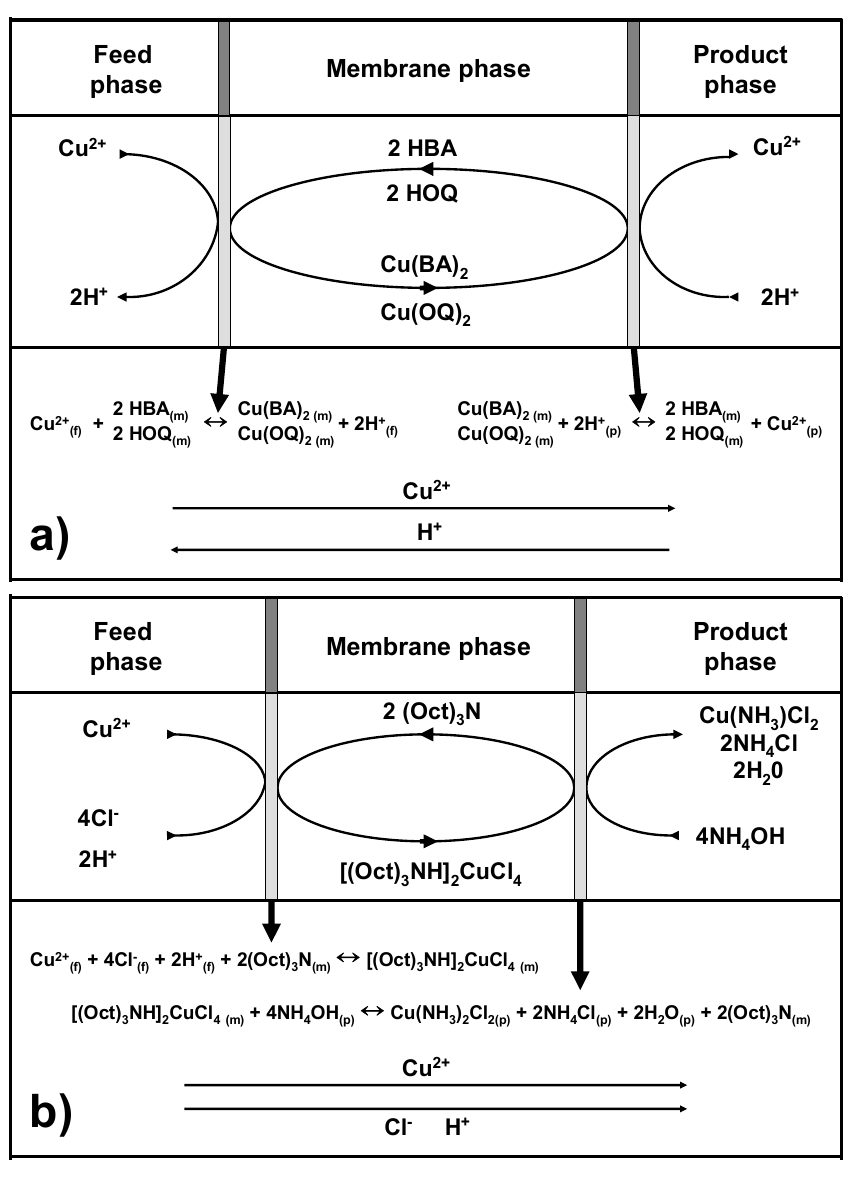
Figure 2. Facilitated transport of Cu(II) through bulk liquid membranes using ( a ) a carrier ‐ mediated counter ‐ transport mechanism and ( b ) a carrier ‐ mediated co ‐ transport mechanism. counter-transport mechanism and ( b ) a carrier-mediated co-transport